Question: Looking at the figure, what chart type is it?
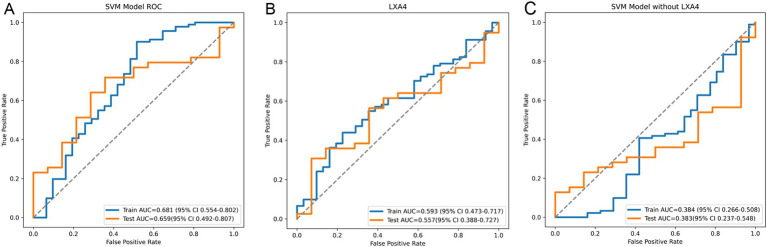
Answer: line